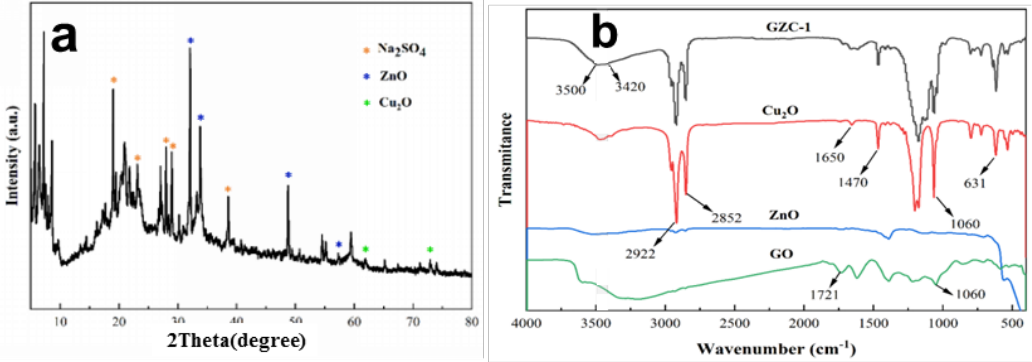
Figure 3. ( a ) XRD pattern. ( b ) FT – IR spectrum of GZC antibacterial powder.